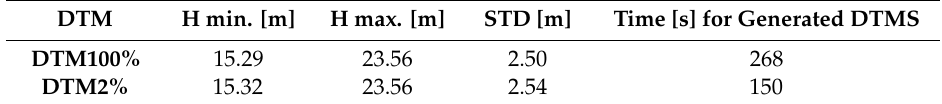
Table 5. Statistical characteristics for DTM100% and DTM2%. (Where: H—height, STD—standard deviation). DTM H min. [m] H max. [m] STD [m] Time [s] for Generated DTMS DTM100% DTM2%